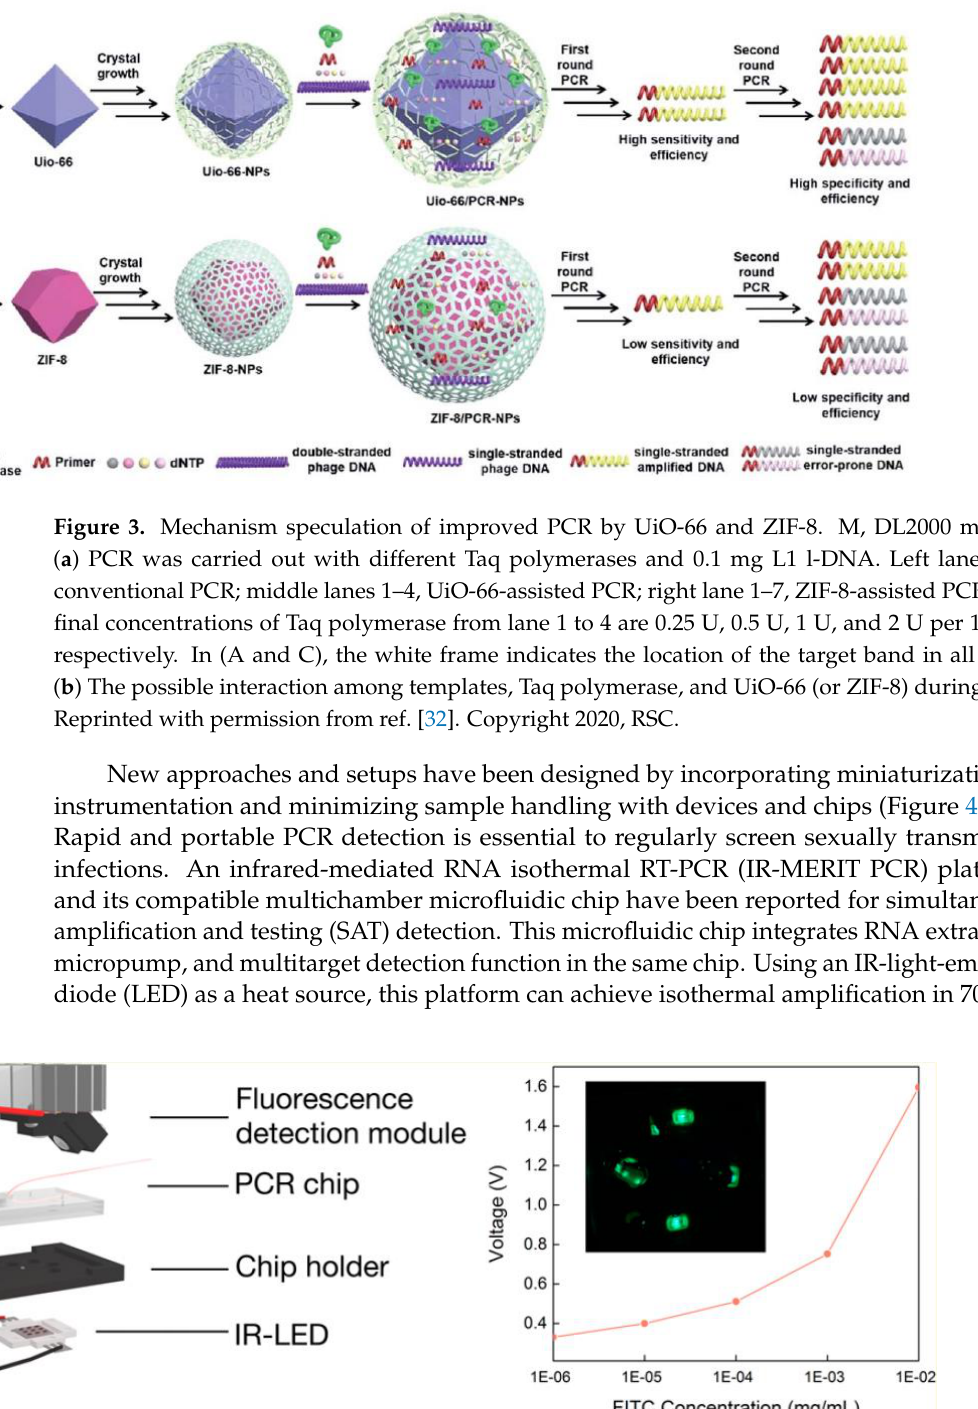
Figure 4. Schema of infrared-mediated RNA isothermal RT-PCR (IR-MERIT PCR) platform and its compatible multichamber microfluidic chip for simultaneous amplification and testing (SAT) detection. This microfluidic chip integrates RNA extraction, micropump, and multitarget detection functions onto the same chip. Insert Image (i) Relationship between fluorescence intensity of FITC Biolabeler at varied concentrations and applied voltage. Embedded picture is a typical laser fluorescence microscopy imaging of the labeled genomic material obtained by this methodology. Reprinted with permission from ref. [33]. Copyright 2018, American Chemical Society.